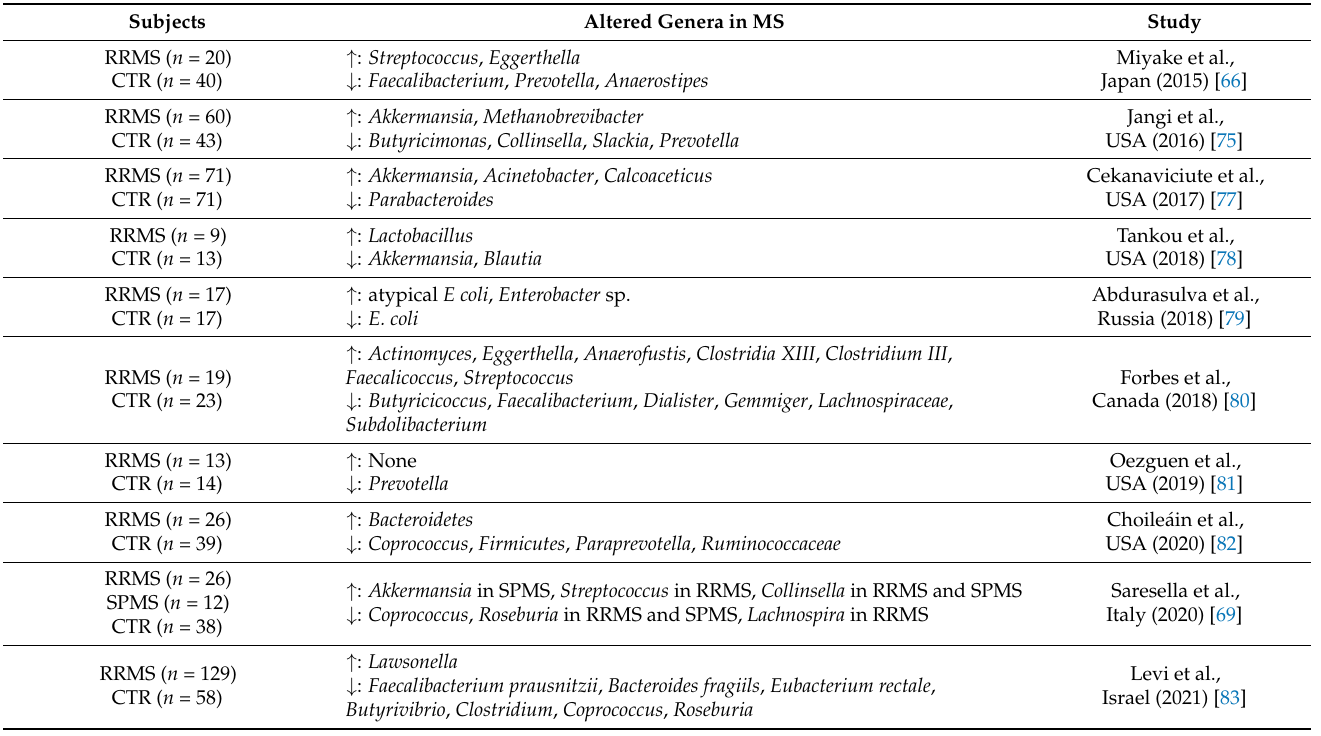
Table 1. Alterations in the gut microbiota of MS